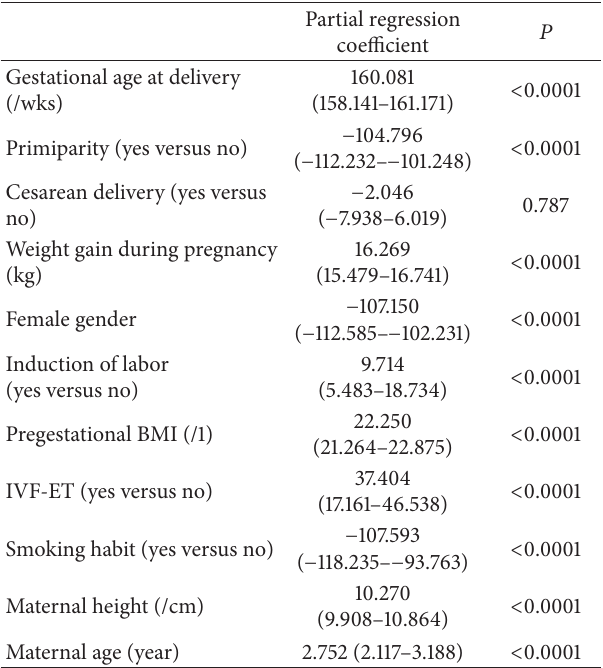
Table 2: Factors affecting the birth weight as determined by a multiple regression analysis